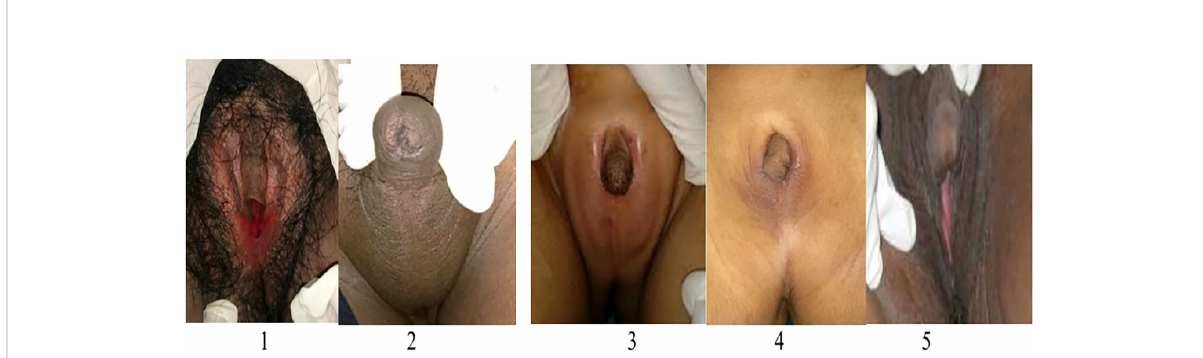
FIGURE 2 Phenotype of external genitalia in a family with CYP11B1 de fi ciency. Patient 1 and 5 identi fi ed as females and presented with clitoromegaly and posterior labial fusion (Prader 3), Patient 2,3, and 4 identi fi ed as males had complete labial fusion and a urethral meatus at the tip of phallus (Prader